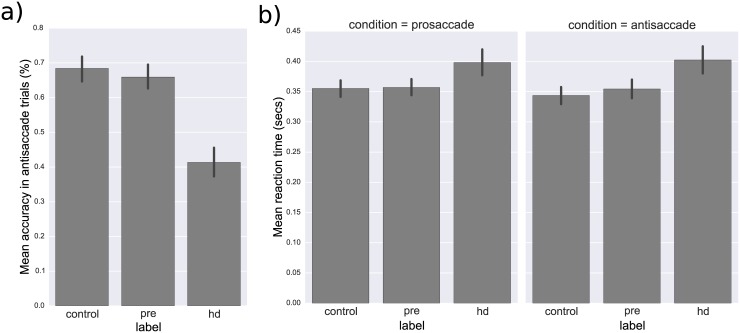
a) Bar-plots of mean reaction time (in seconds) across different groups. b) Bar-plots of mean percent accuracy during antisaccade trials across different groups. Error-bars depict 95% confidence intervals.